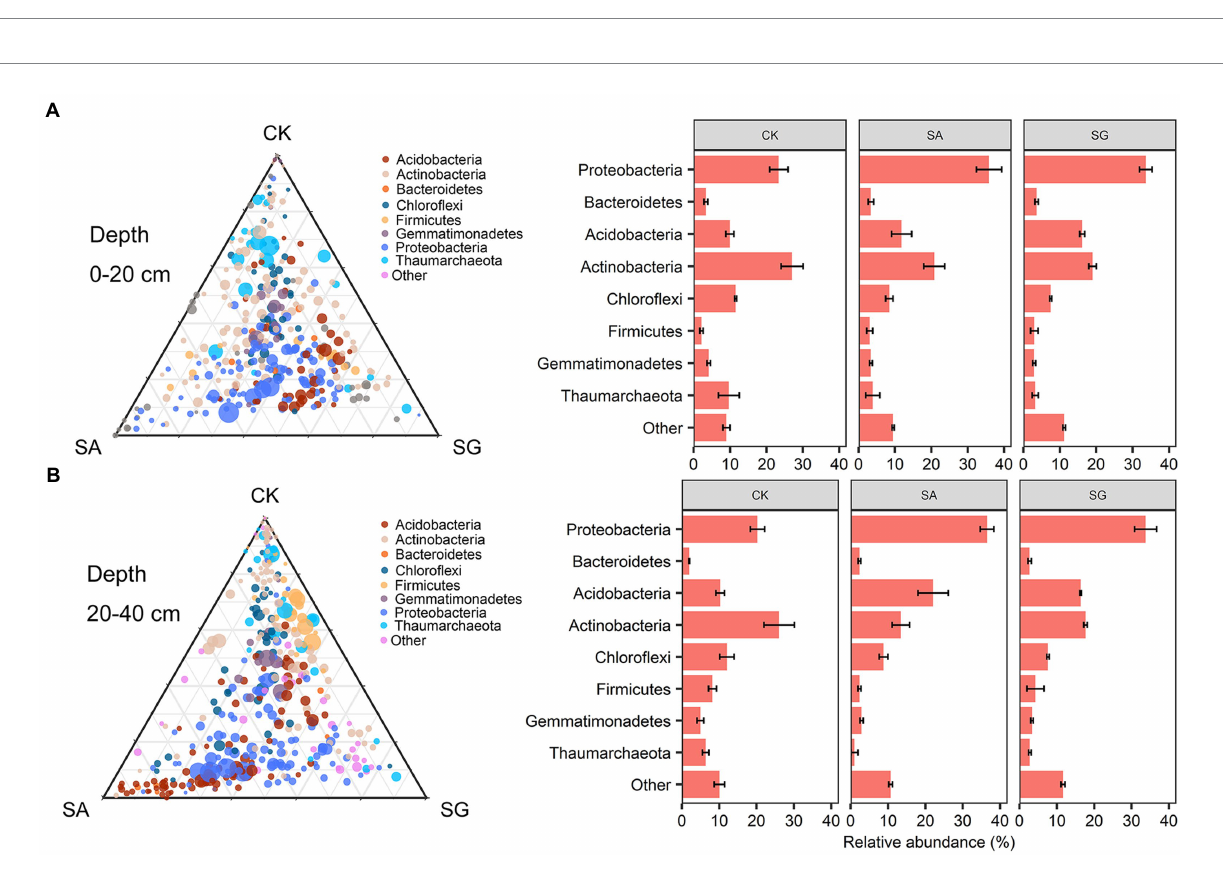
FIGURE 3 Taxonomic distribution of bacterial taxa responsible for community different among different restoration modes at 0–20 cm (A) and 20–40 cm (B) soil